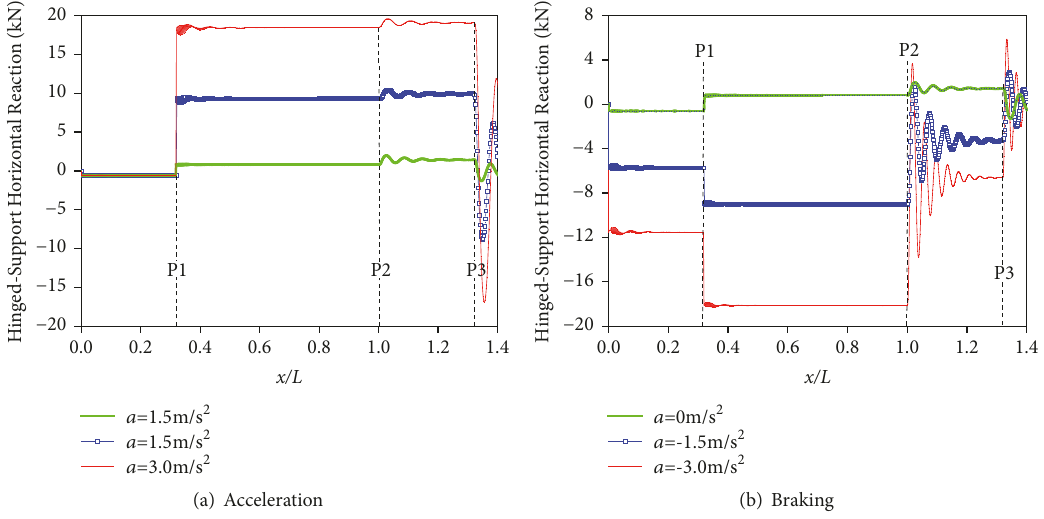
Figure 13: Longitudinal reaction at hinged support of simply supported